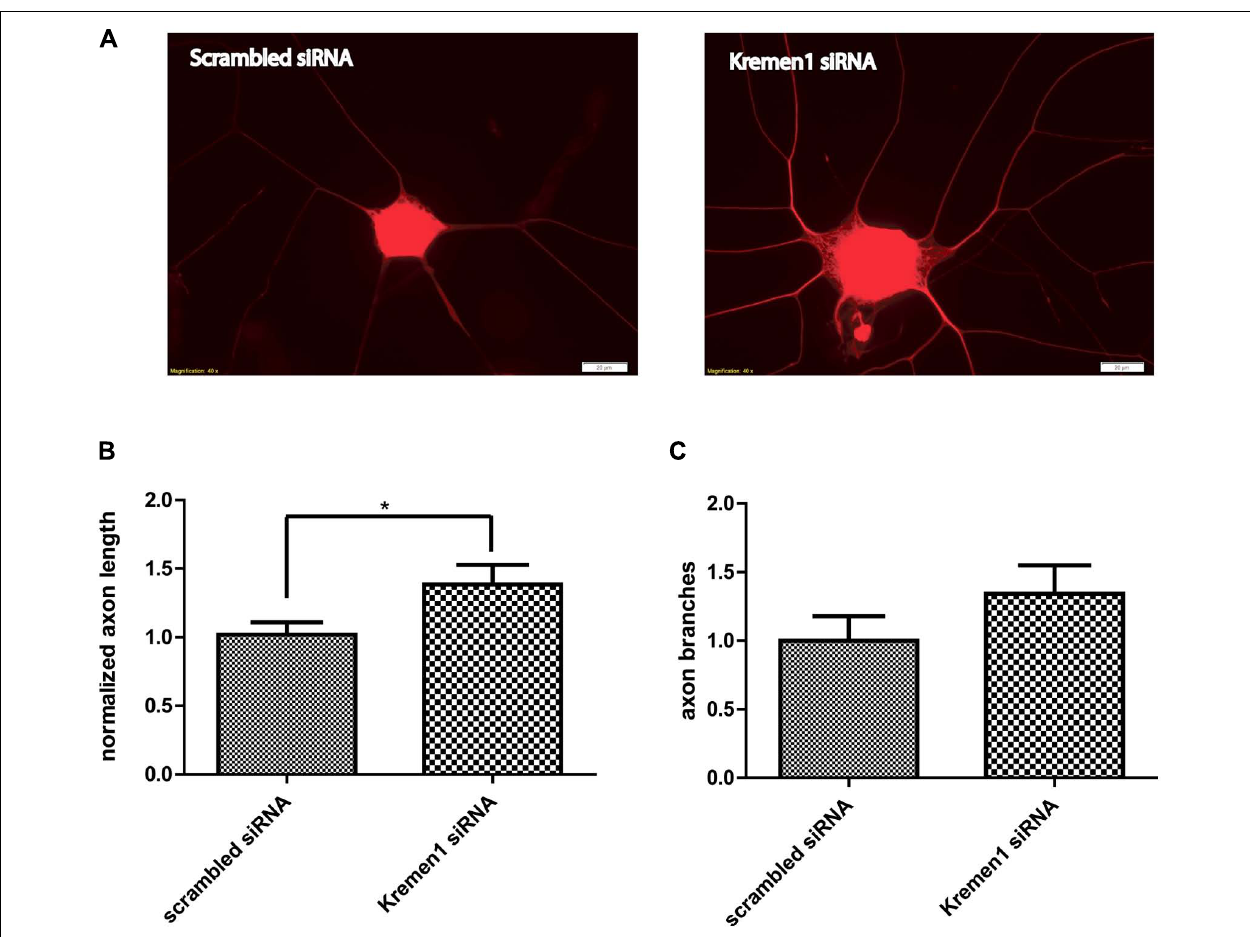
functional analysis, we measured the length of the longest axon for each neuron (B) and counted the number of branches for each neuron (C) . Inhibition of Kremen1 significantly increased the length of axon, however, its effect on neurite branching was not significant. * − p < 0.05. For the analysis of two independent groups, Student’s t -test was used. Scale bar: 20 μ